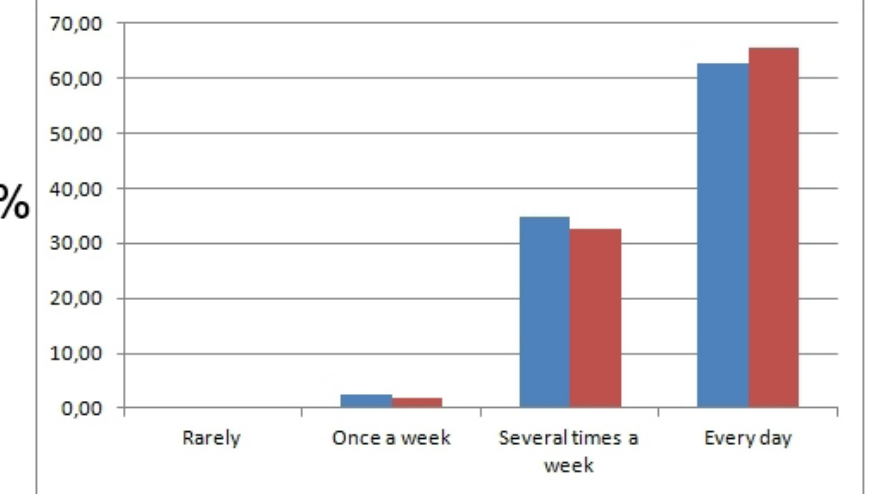
Figure 2. Internet usage of the students enrolled in the course. The y axis represents the percentage of students that chose the particular answer. Blue and red bars represent responses acquired before and after the course,